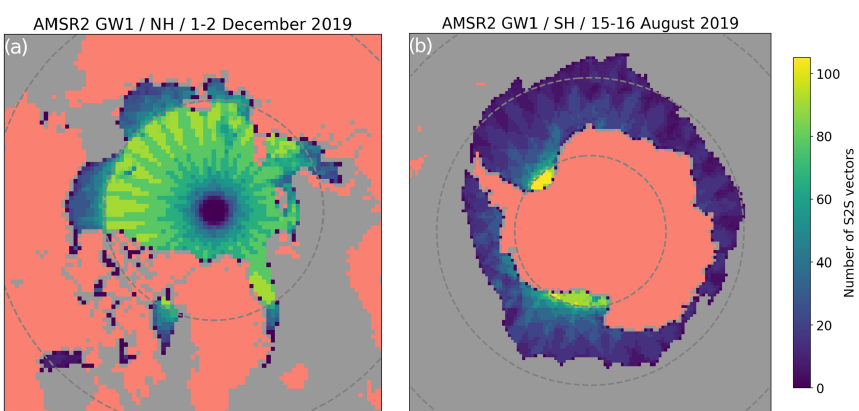
Figure 3. (a) Number of S2S vectors per grid cell in the Northern Hemisphere for the period of 1–2 December 2019 and GCOM-W1 AMSR2 mission. (b) Same quantity but for the Southern Hemisphere and for the period of 15–16 August 2019. Parallels at ± 75 and ± 60 are